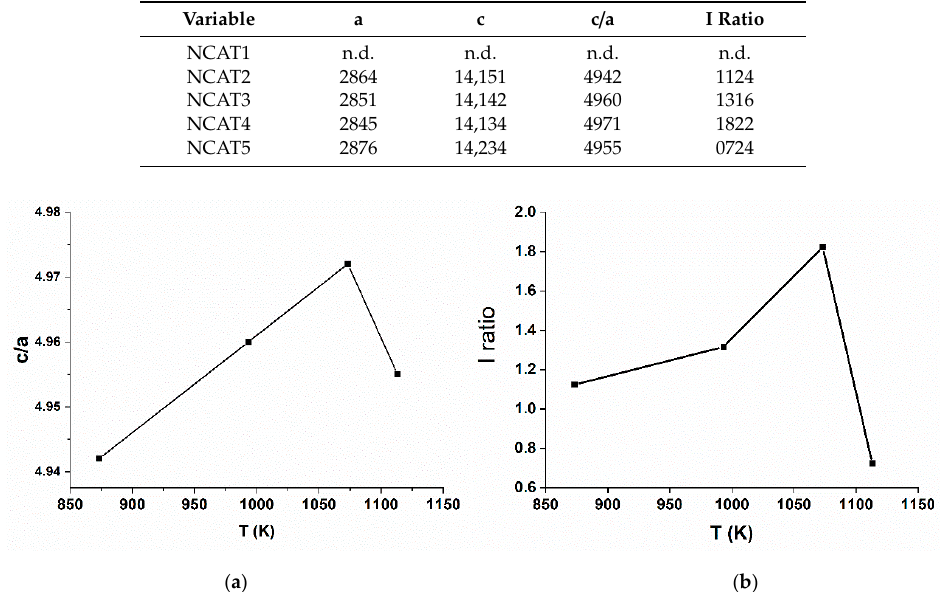
Figure 8. ( a ) Lattice parameters and ( b ) I ratio of as-prepared NCA samples sintered at various absolute temperature.